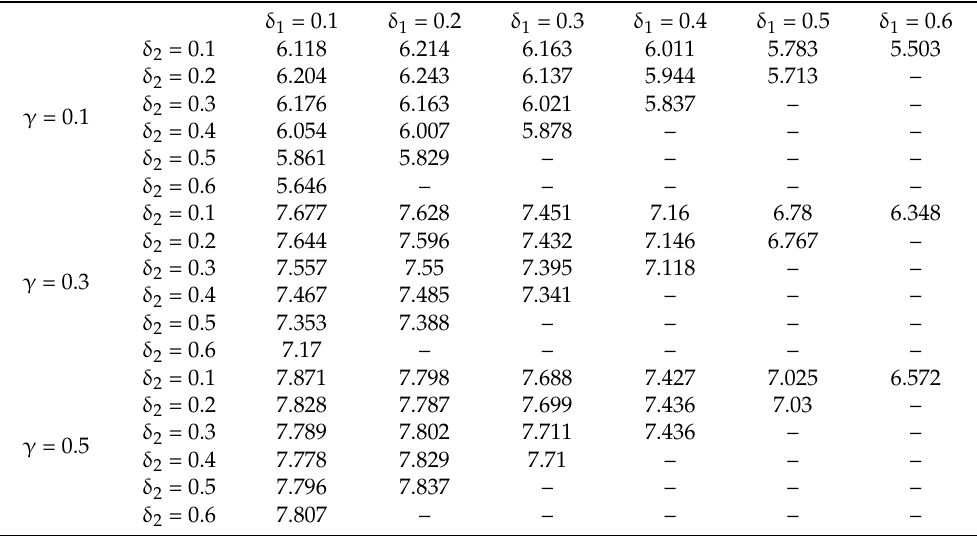
Table 1. Average Nusselt number at vertical wall in the case of two porous fins for distance between fins, distance from the bottom wall to the first fin and length of fins when Da = 0.01.